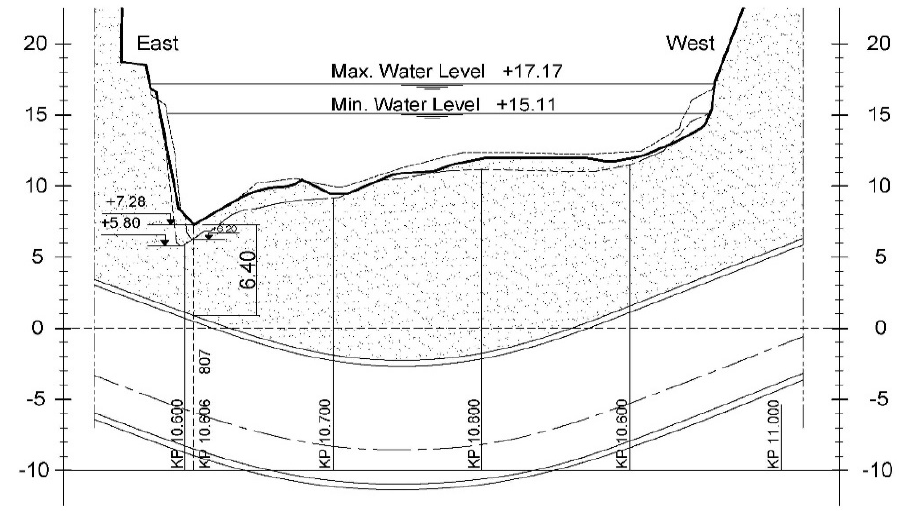
Figure 4. Tunnel section under the east branch of the Nile River.